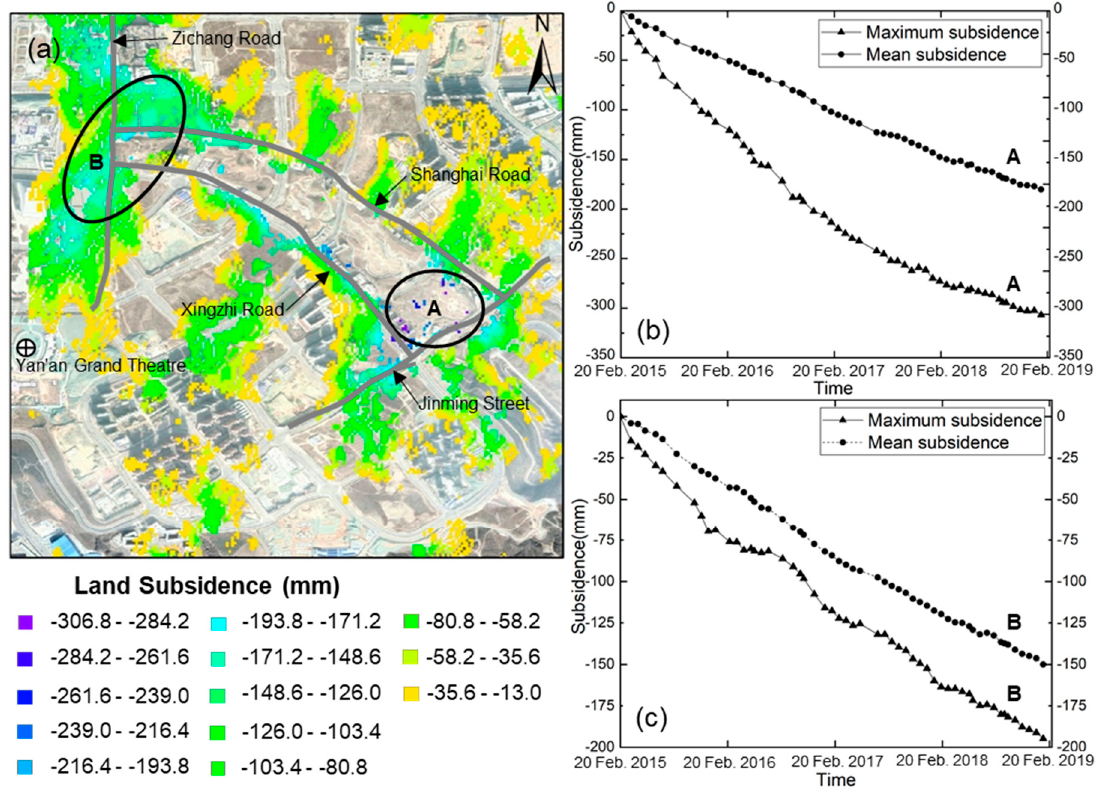
Figure 5. ( a ) The subsidence zone in YND superimposed on the Google Earth image; ( b ) and ( c ) represent the evolution of land subsidence of regions A and B, respectively.